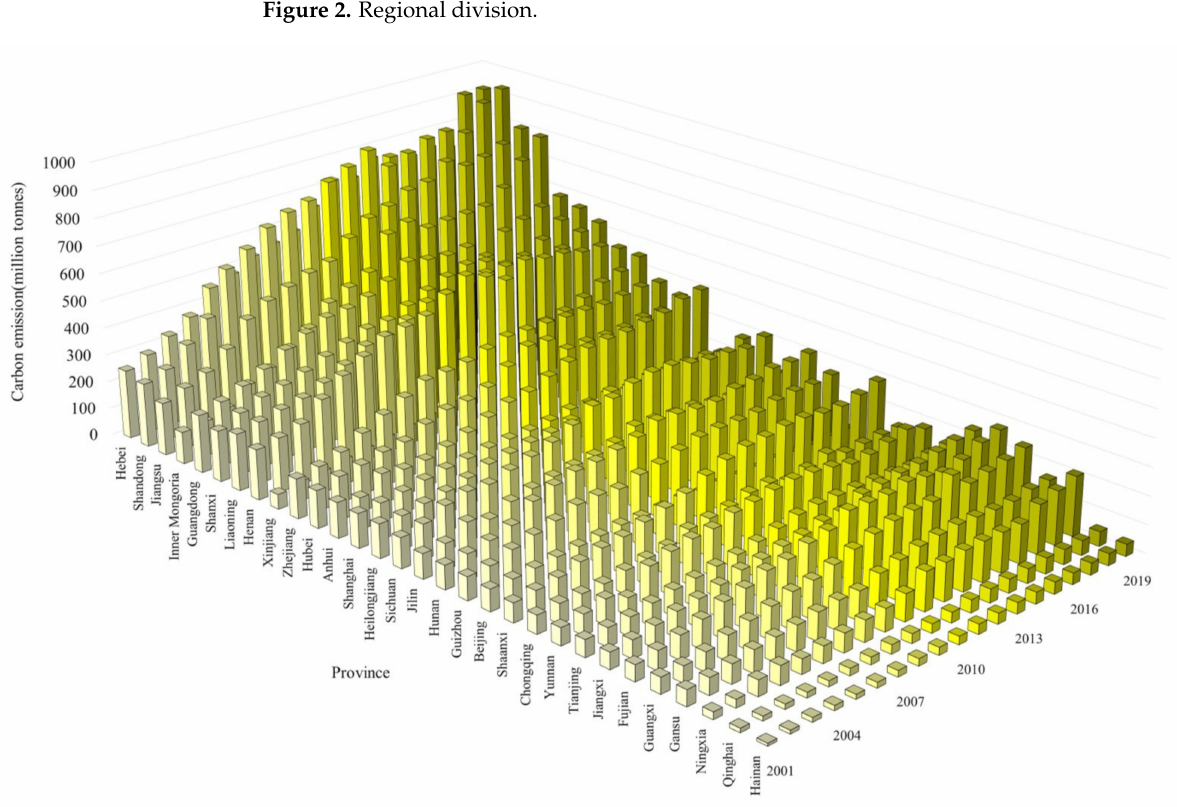
Figure 3. Statistics on carbon emissions by